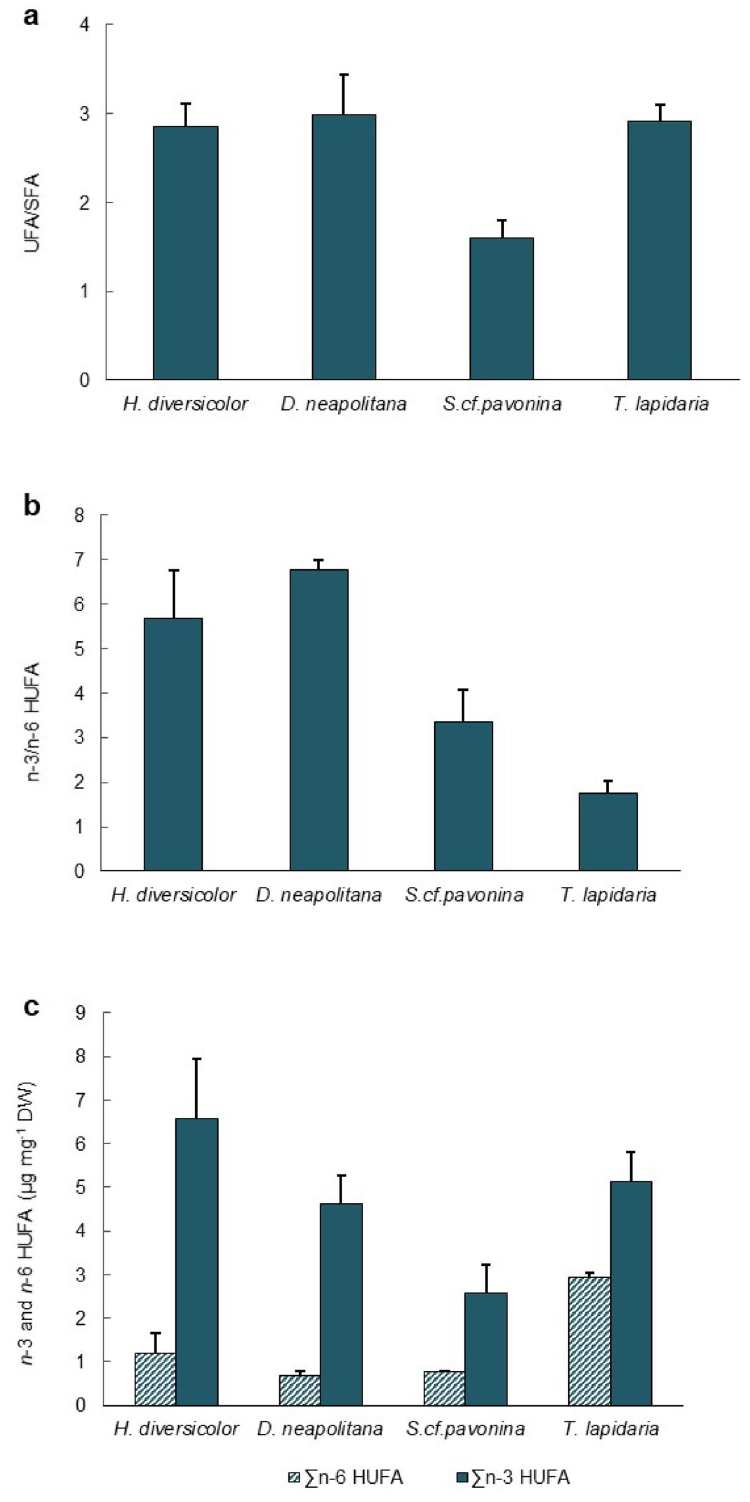
Figure 3. Fatty acid profile of different IMTA-cultured polychaetes ( Hediste diversicolor, Diopatra neapolitana, Sabella cf. pavonina and Terebella lapidaria ): ( a ) unsaturated and saturated fatty acids ratio (UFA/SFA); ( b ) n - 3/ n -6 highly unsaturated fatty acids ratio ( n -3/ n -6 HUFA); ( c ) sum of n -3 and n -6 highly unsaturated fatty acids content (∑n-3 and n-6 HUFA; values in µg mg −1 DW). Average values ± SD (n =